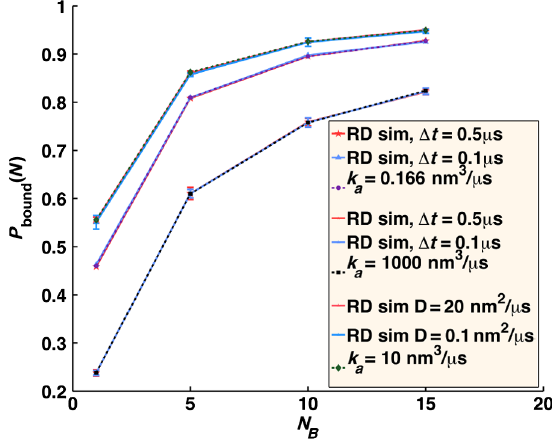
FIG. 9. Equilibrium association probability [Eq. (24)] for systems with a central A particle and N B ¼ 1 , 5, 10, and 15 B particles uniformly distributed throughout the volume. Lines are guides to the eye. Dashed lines connect the theoretical values, and red and blue lines connect the simulated values shown with error bars. From top to bottom, the green diamonds are results for k 10 nm 3 = μ s us, k 1 s − 1 , and V ¼ 8 × 10 6 nm 3 , and the a ¼ b ¼ corresponding RD simulations use Δ t ¼ 0 . 1 μ s and D AB ¼ 20 and 0 . 1 nm 2 = μ s. The purple circles are k a ¼ 0 . 166 nm 3 = μ s, k 0 . 1 s − 1 , and V ¼ 1 . 95 × 10 6 nm 3 , and the corresponding b ¼ RD simulations use D AB ¼ 5 nm 2 = μ s, Δ t ¼ 0 . 5 μ s, and Δ t ¼ 0 . 1 μ s. The black squares are k 1000 . 0 nm 3 = μ s, a ¼ k 50 s − 1 , and V ¼ 64 × 10 6 nm 3 , and the corresponding b ¼ RD simulations use D AB ¼ 20 nm 2 = μ s, Δ t ¼ 0 . 5 μ s, and Δ t ¼ 0 . 1 μ s. The binding radius is always 1 nm. Simulations are run for the duration of 5000 binding events to converge the bound probability, and 10 – 20 different simulations were run for each data